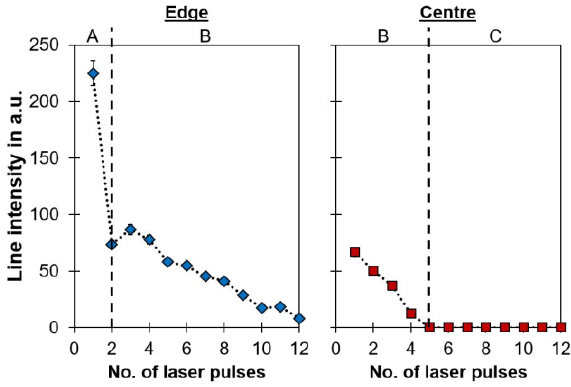
Fig. 2. Comparison of the intensity of the Al I 396.15 nm transition vs. number of successive laser pulses at different positions on the surface of commercial fused silica plates (left: edge, right: centre).